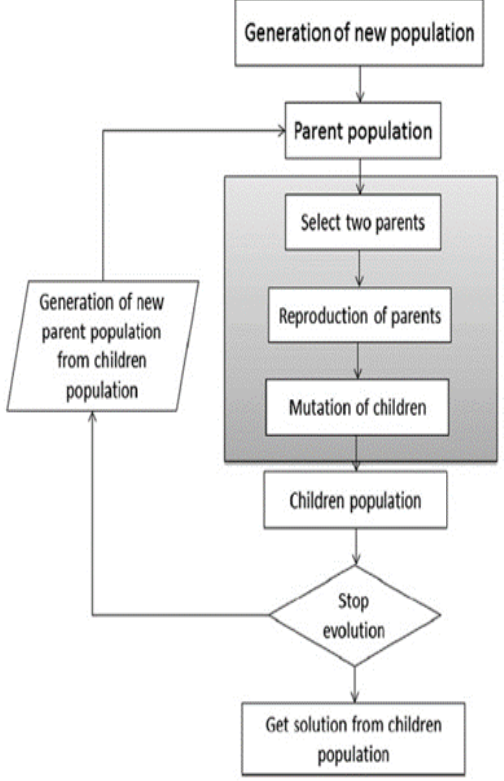
Figure 3. GA Flowchart.